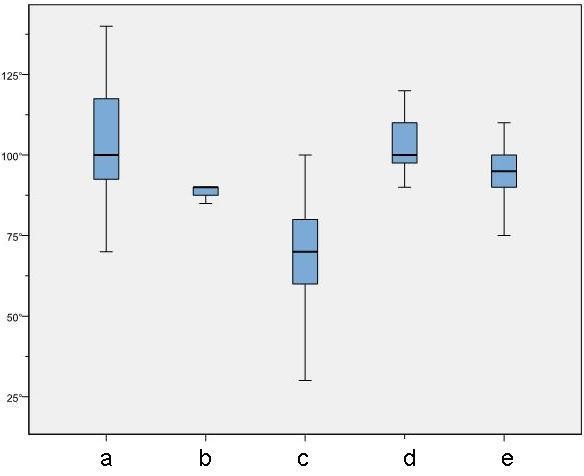
Box-plot-diagram (Min, 25% Quantil, Median, 75% Quantil, Max) showing flexion to different points of time. a) before TKA; b) after TKA; c) before MUA; d) after MUA; e) six weeks after MUA. A statistical significant change in flexion was seen between the different points of time (p ≤ 0.001).